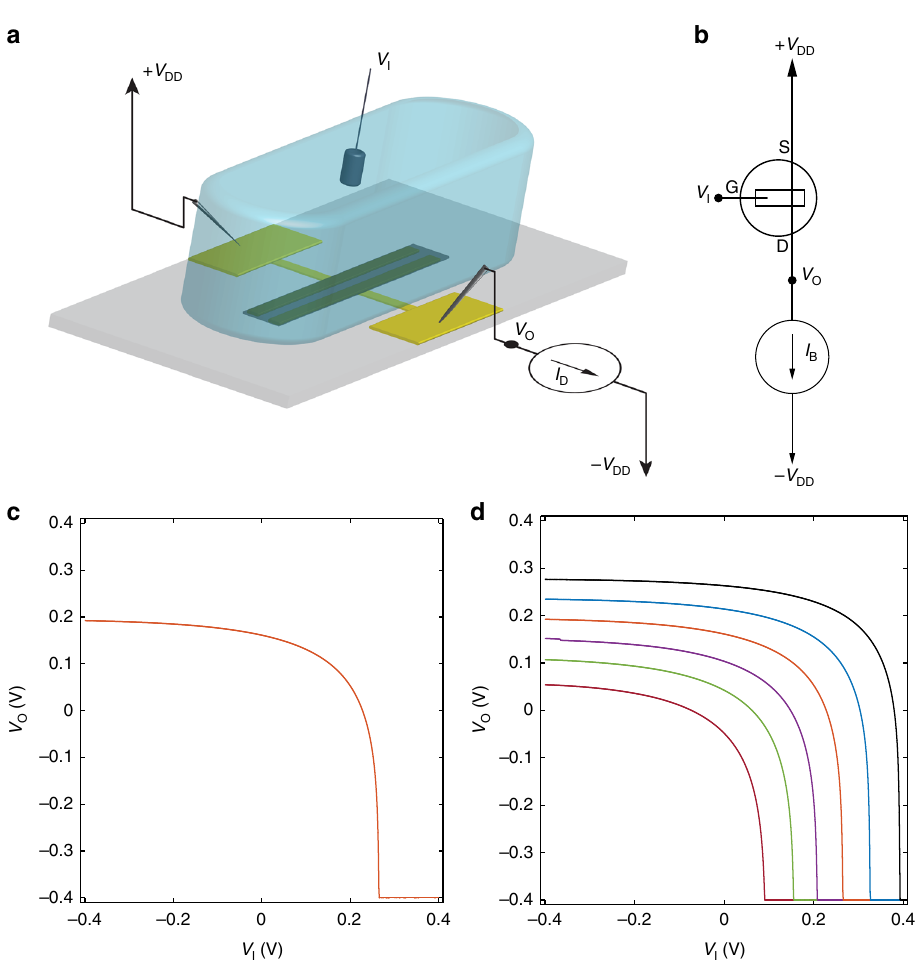
Fig. 2 Current-driven OECT architecture and electrical characteristics. a Current-driven OECT con fi guration. b Schematic of the current-driven OECT. c Measured transfer characteristic of a current-driven OECT at I B = 1.25 mA and V DD = 0.4 V. d Measured transfer characteristics of a current-driven OECT by varying the bias current from I B = 2.0 mA (brown curve) to I B = 0.75 mA (black curve) with a step of − 0.25 mA, V DD = 0.4 V. The gate is a Ag/AgCl pellet and the OECTs geometries are: W = 1000 µ m, L = 50 µ m, t = 50 nm. The NaCl concentration is 1 bias current I B . Figure 2d shows the transfer characteristics V O – V I of the current-driven OECT for several current biases I B .